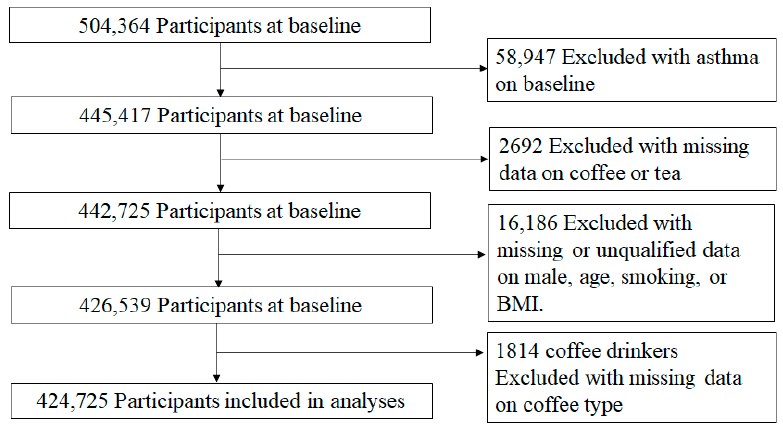
Figure 1. Flowchart of participant selection.